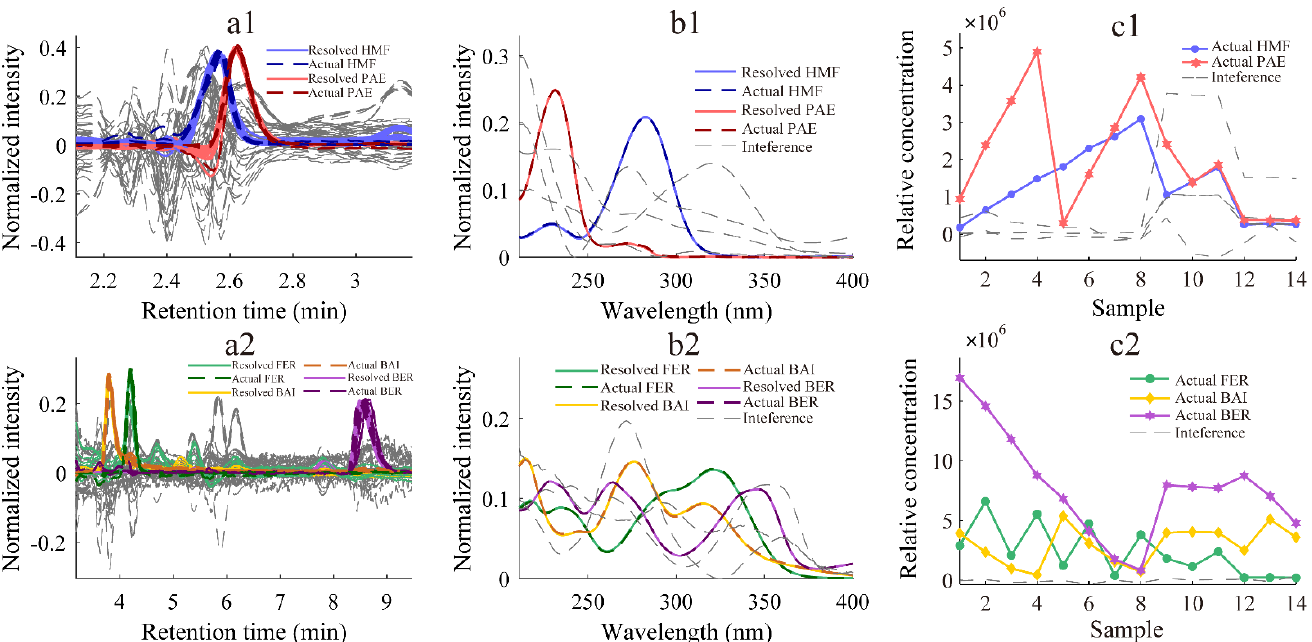
Figure 3. The normalized chromatograms ( a1 , a2 ), the normalized spectrograms ( b1 , b2 ), and the relative concentration profiles ( c1 , c2 ) resolved by the ATLD − MCR algorithm from two three − way subarrays.